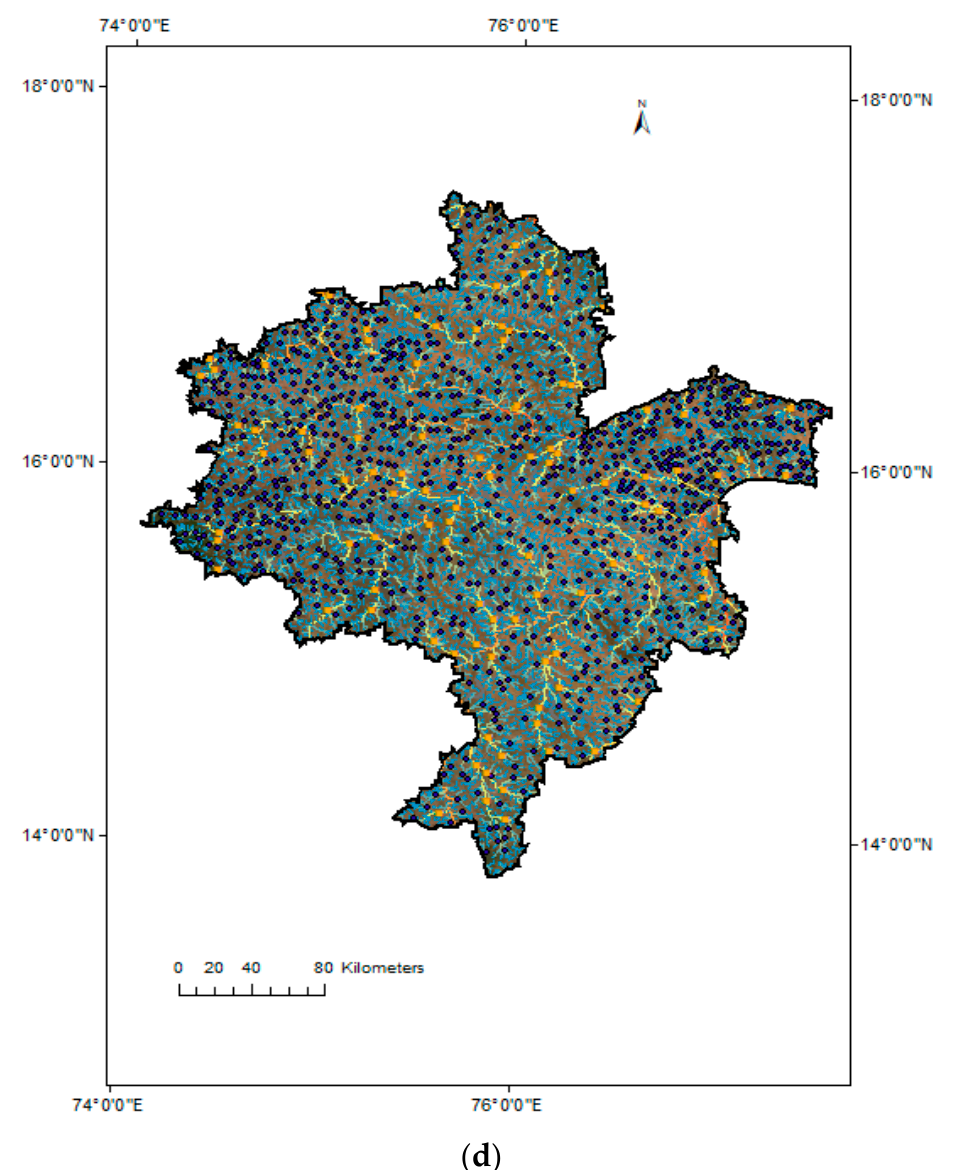
Figure 9. ( a ) Suitable in situ interventions identified for northern dry zone of Karnataka. ( b ) Stream order map of the study area. ( c ) Potential locations for water-harvesting/recharge structures identified for northern dry zone of Karnataka. ( d ) Validation of potential locations for water- harvesting/recharge structures. Table 6. Validation of different in situ interventions in different villages of northern dry zone of Karnataka.